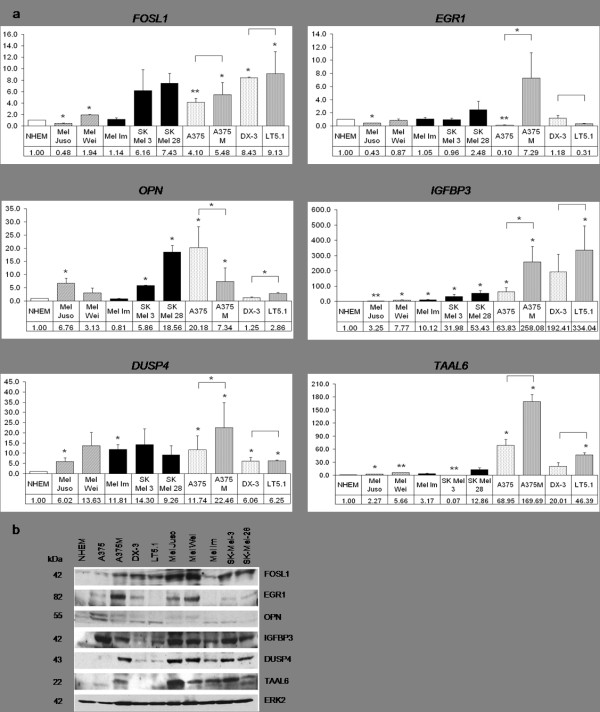
Expression of candidate genes in human melanoma cell lines. a, Realtime PCR was performed to determine FOSL1, EGR1, OPN, IGFBP3, DUSP4 and TAAL6 expression in human melanoma cell lines compared to NHEM cells. Fold change of transcript, referred to NHEM cells, is indicated. β-actin was used as reference gene. Significant (p < 0.05) or highly significant (p < 0.001) regulation are marked by one or two asterisks, respectively (Student's t-test, paired, one-tailed).b, Western blot analysis of the candidate genes in human melanoma cell lines. Expression of ERK2 served as loading control. Please note that the order of cell lines differs from A. On the OPN blot, the lower band represents the OPN protein. For TAAL6, the upper band corresponds to the protein of the expected size.